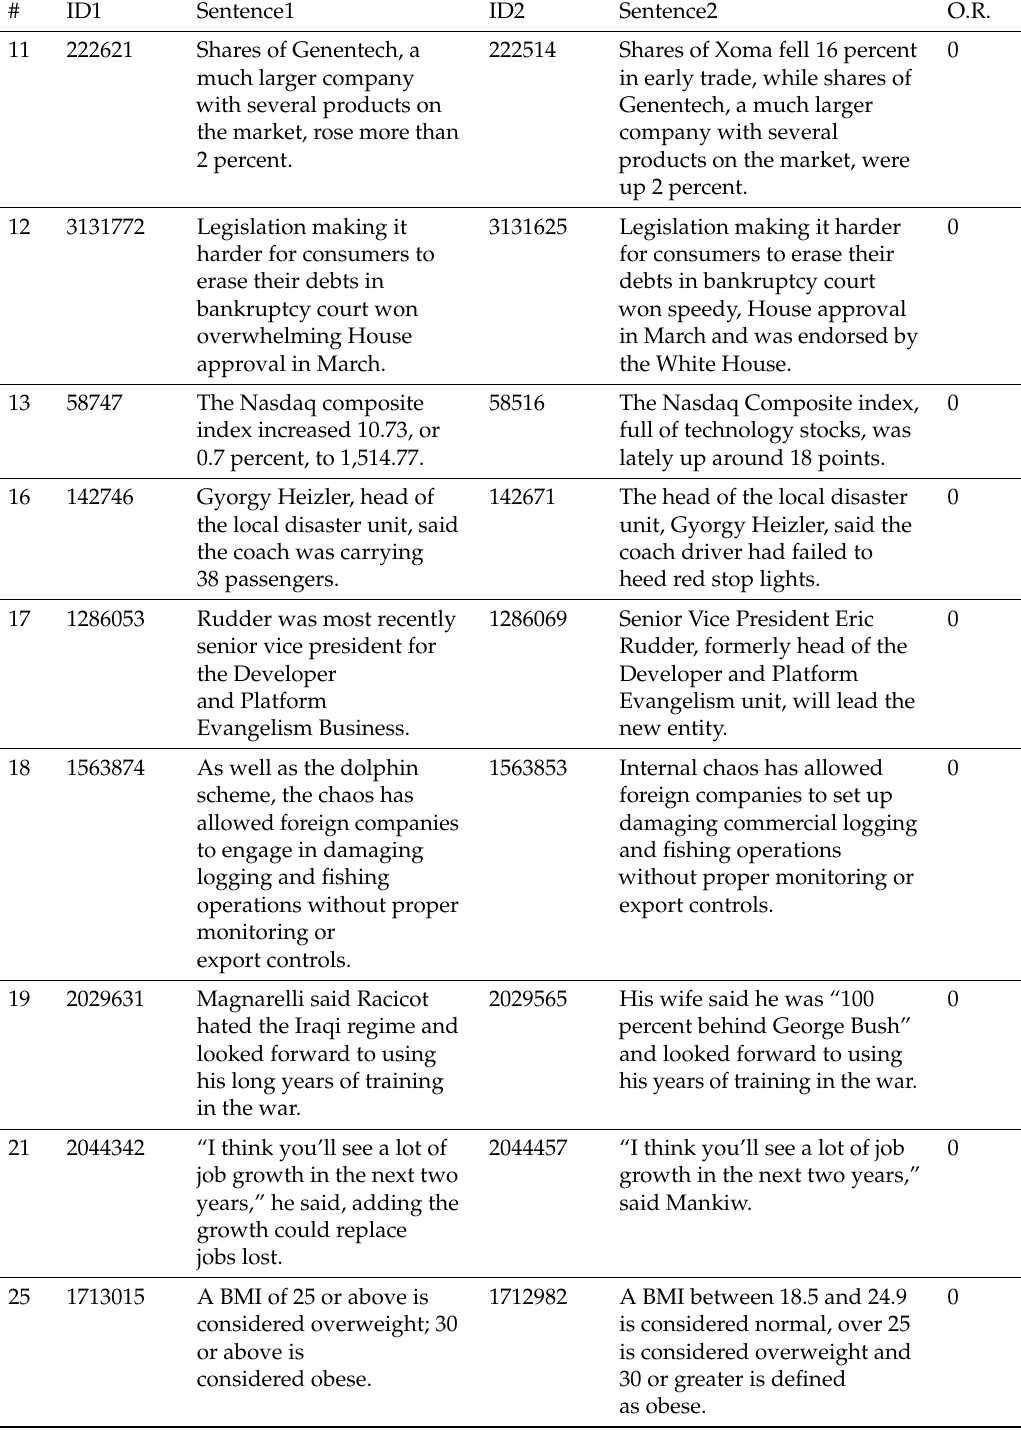
Table A2. Some O ffi cial Annotations for the Initial 25 Pairs of MSRP